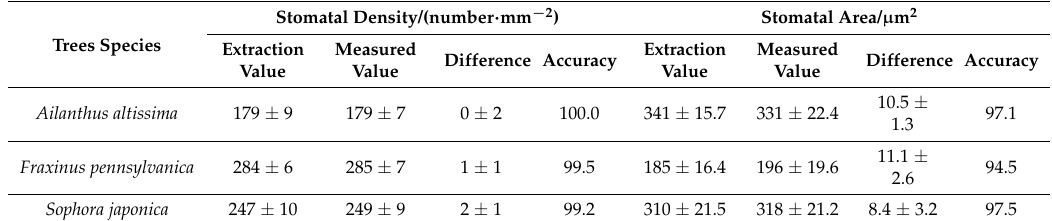
Table 4. Accuracy of stomatal extraction.